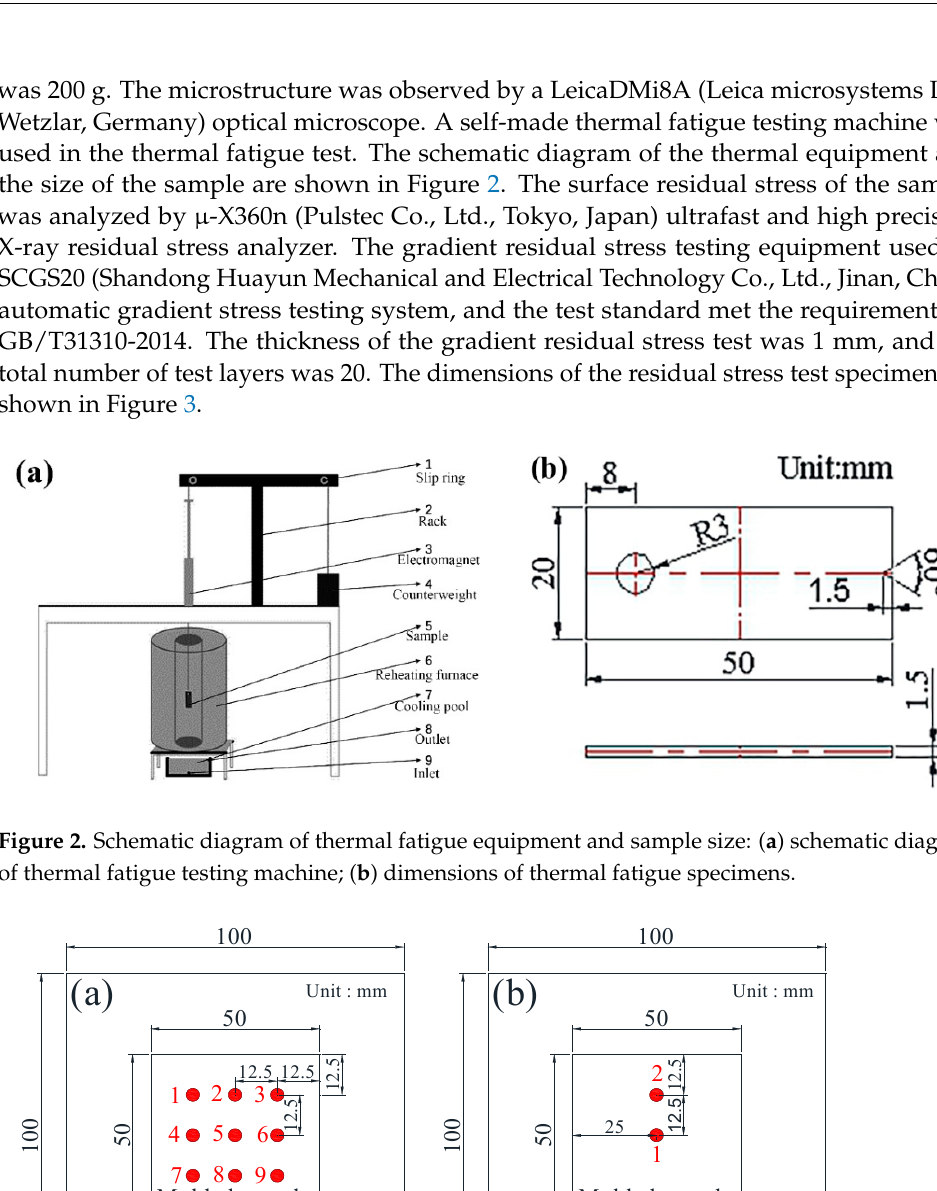
Figure 3. Residual stress test point: ( a ) diagram of surface residual stress test; ( b ) gradient residual stress test diagram.